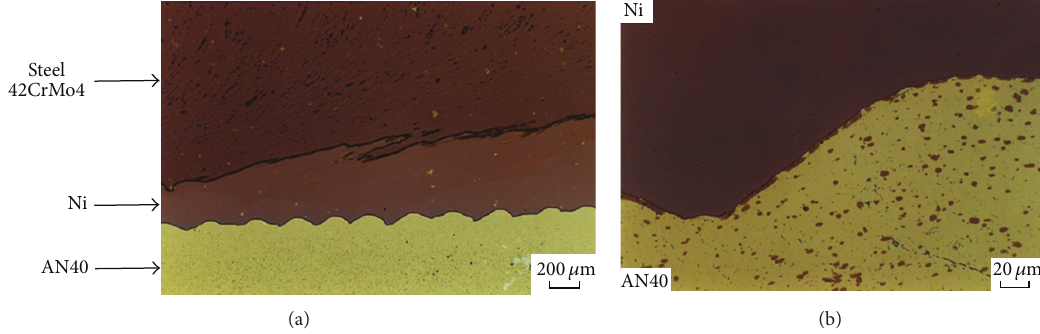
Figure 24: The microstructure of the 42CrMo4 steel-AN40 alloy joint with the nickel interlayer (a) and a fragment of an enlarged microstructure of the nickel-AN40 alloy bounding zone